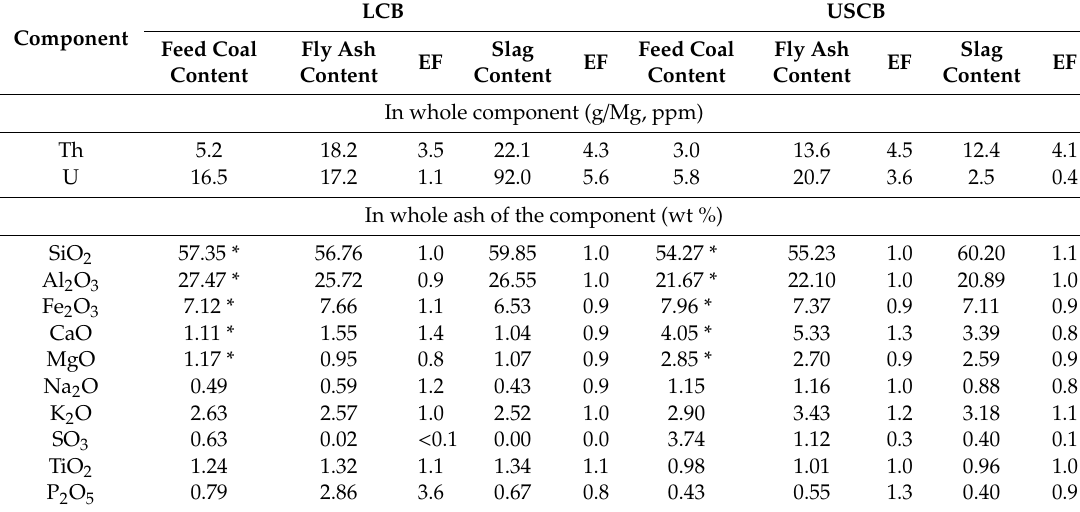
Table 2. The average content of Th and U in the feed coal from the Lublin (LCB) and Upper Silesian Coal Basin (USCB) and in fly ash and slag, and enrichment factor values (EF).